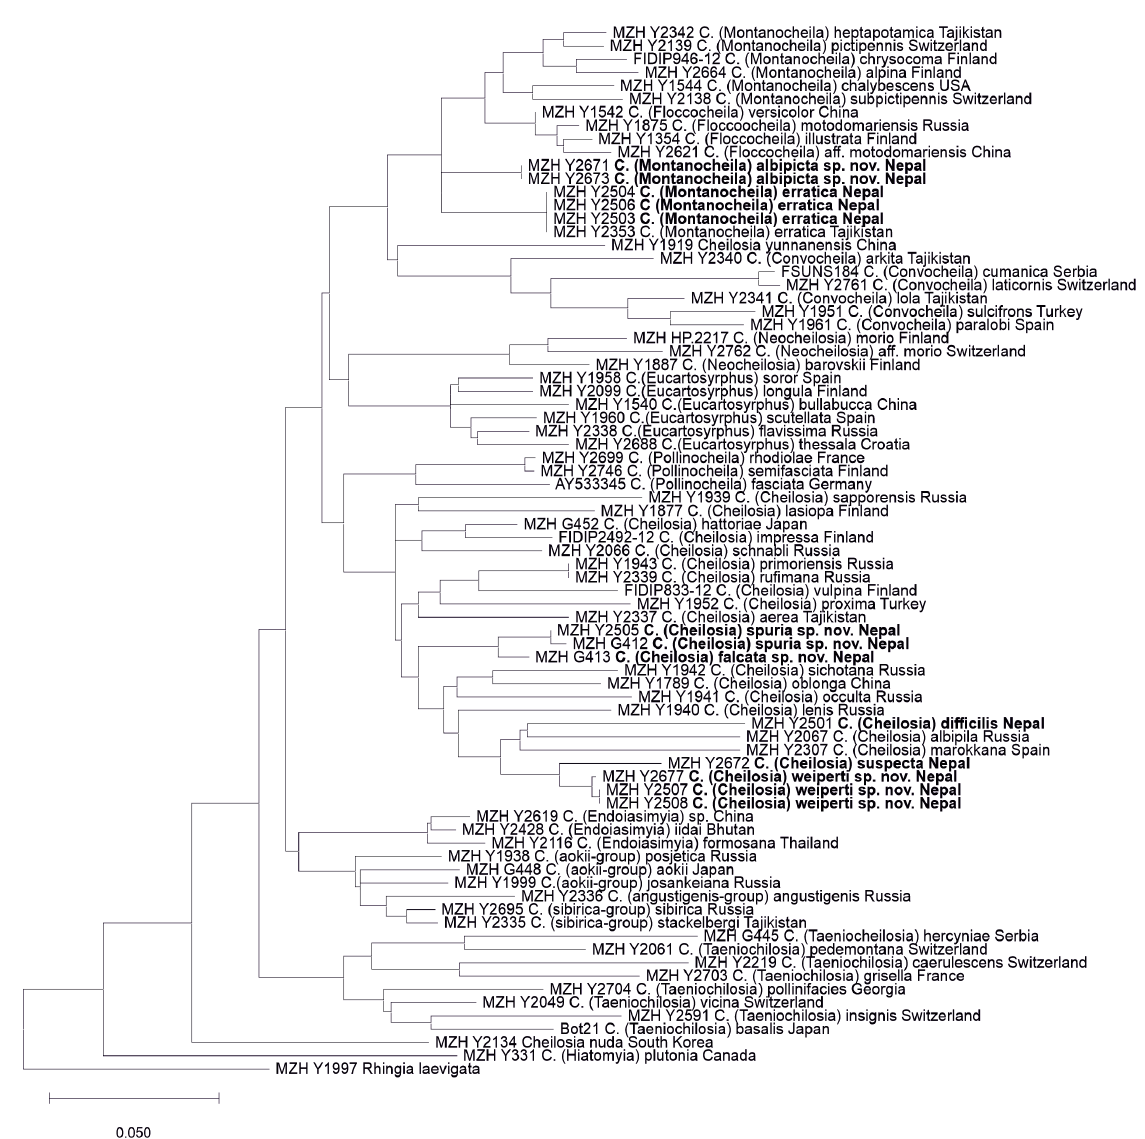
Fig. 1. Maximum likelihood tree based on mtDNA COI barcodes. Species labelled with subgeneric or species group membership. Taxa from Nepal in